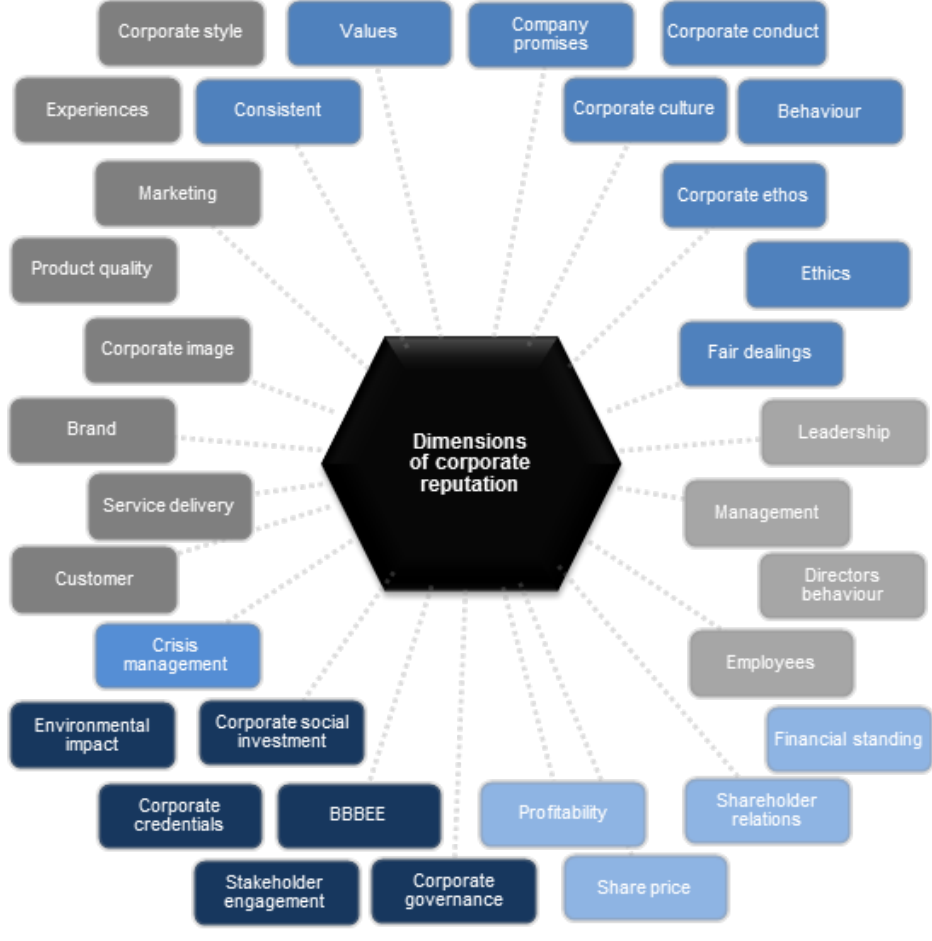
Figure1: Dimensions of corporate